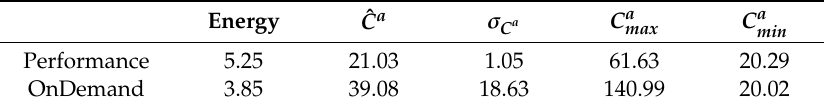
Table 10. Interactive governor with conf1 and different F hs values. Vid1.